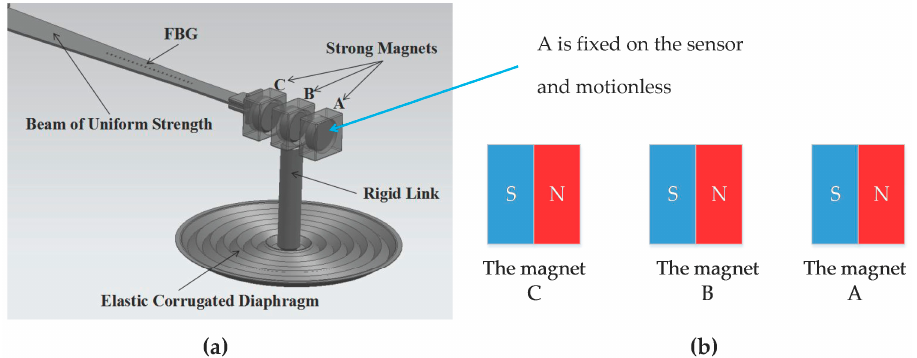
Figure 4. ( a ) The structure of sensitive unit with magnetic transfer; ( b ) the relationship of magnets A, B and C.